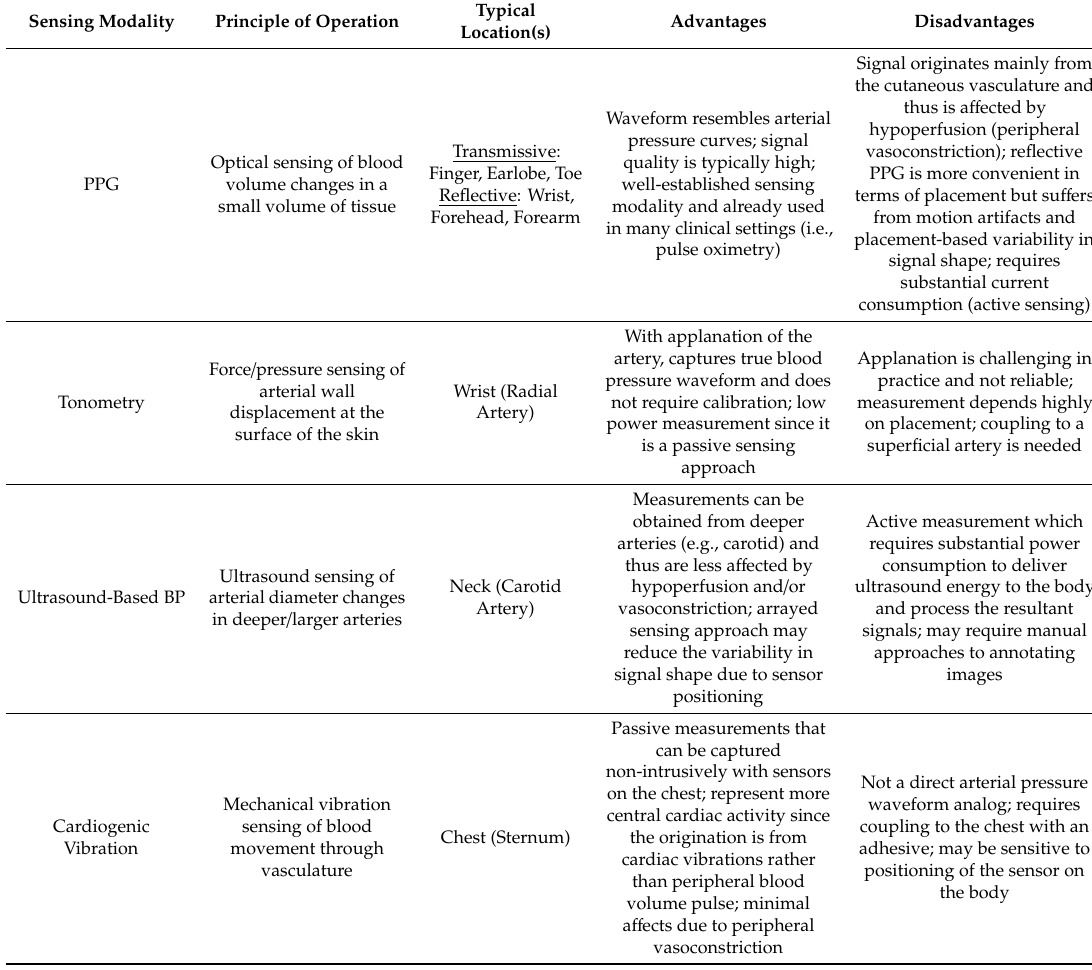
Table 3. Comparison of Sensing Technologies for Arterial Pulse Waveform